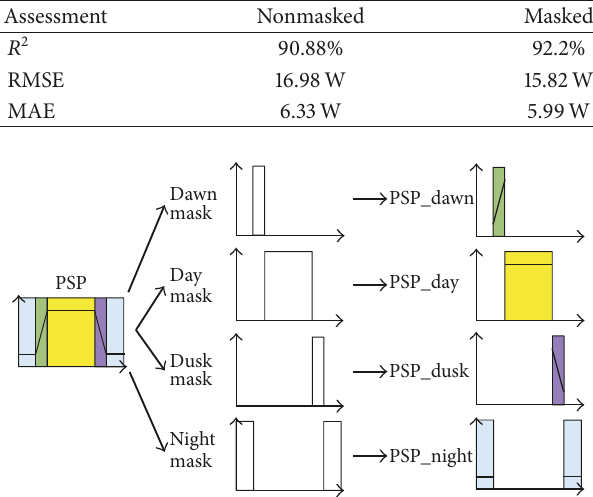
Figure 6: The impact of masking on the PSP inputs. The same masking was applied to the NIP and MPP